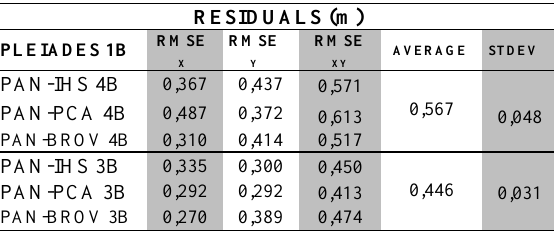
Table 2: Resulting residuals for all experiments on Pleiades 1B panchromatic data compared with the pansharpened data.